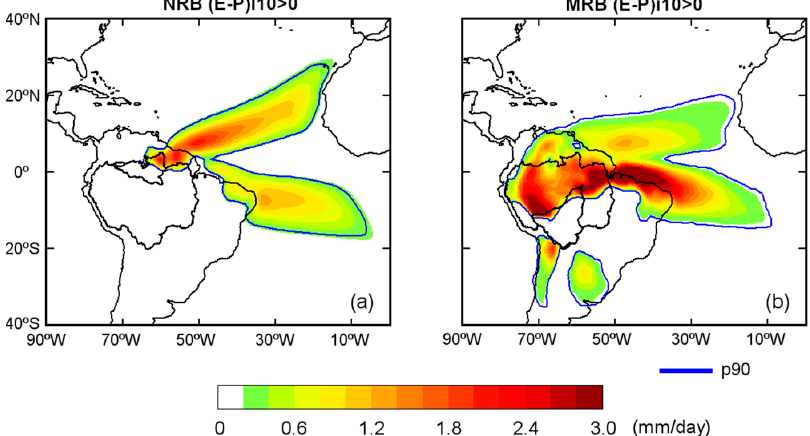
Figure 5. Annual (E − P)i10 > 0 budget obtained in the backward in time experiment for the NRB ( a ) Figure 5. Annual ( E − P ) i10 > 0 budget obtained in the backward in time experiment for the and MRB ( b ). Period: 1980–2016.